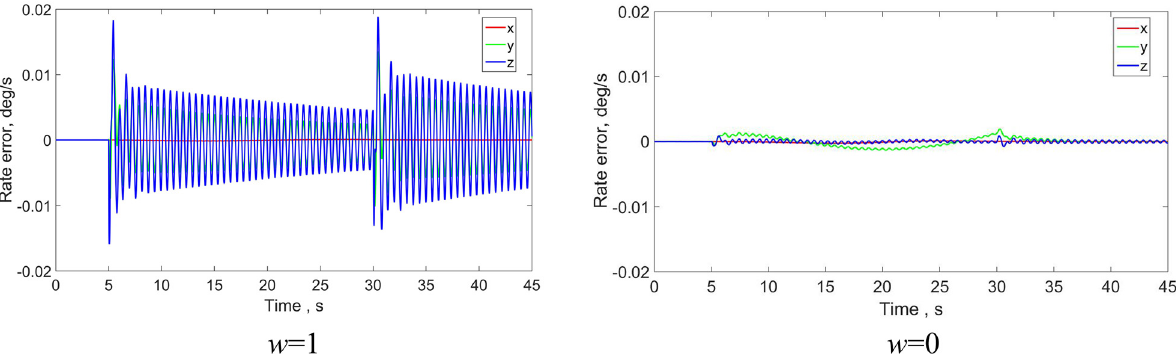
Figure 26: Rate attitude errors for case 1.